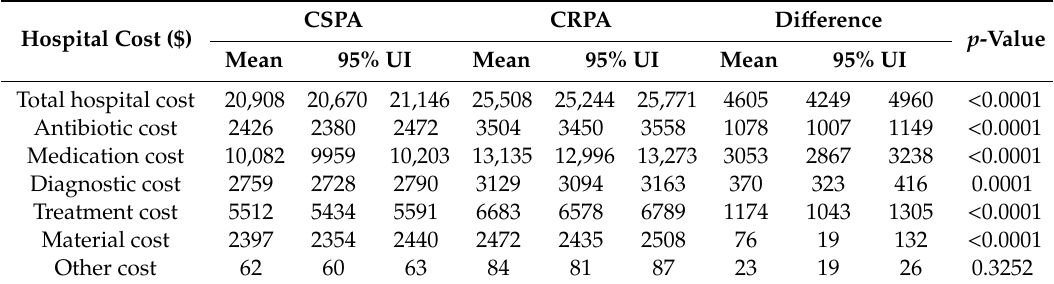
Table 5. Economic costs of patients with CRPA and CSPA after PSM for potential confounding variables.